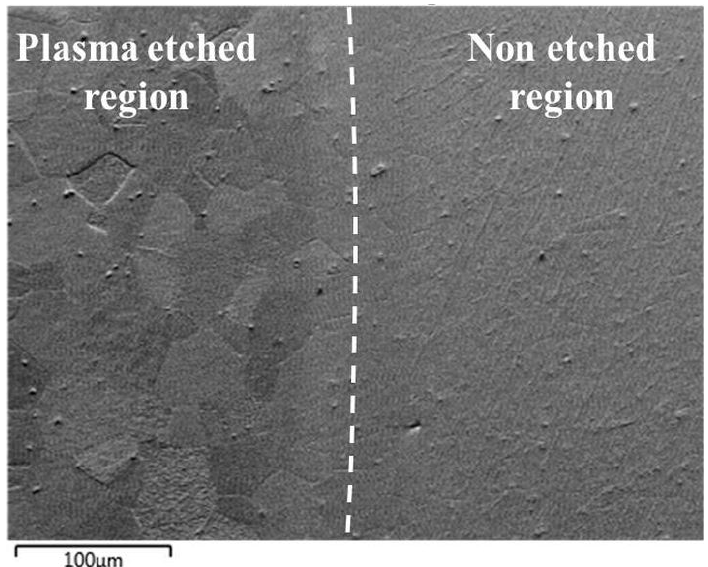
Figure 7. EBSD images of sputtered area of steel 1.4521 (AISI 444).